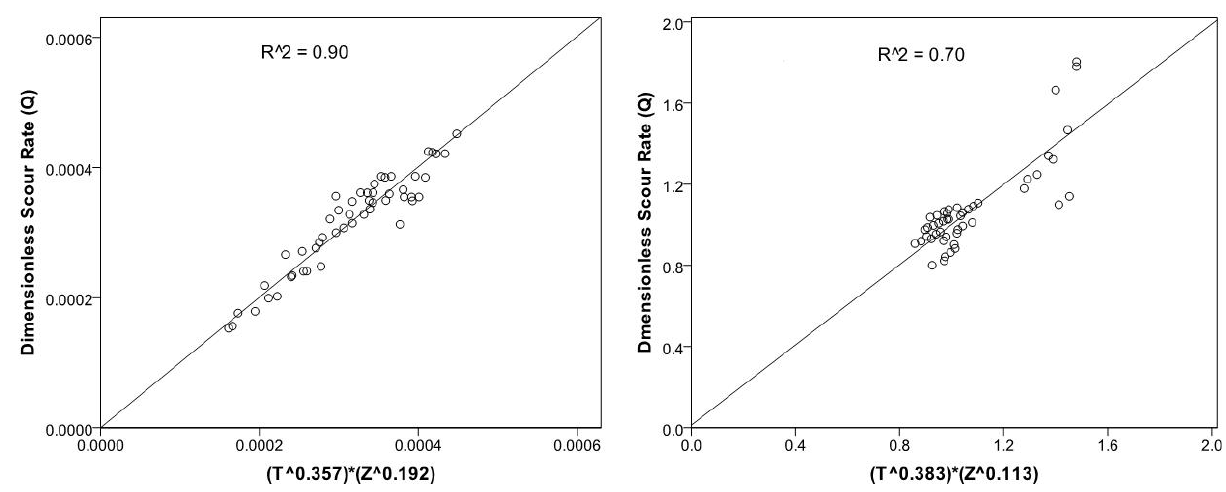
Figure 9: Relationship of dimensionless erosion rate with dimen- sionless shear stress and soil protrusion for smooth bed condition.